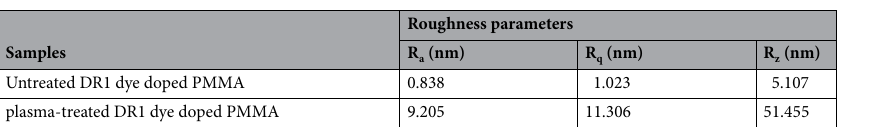
Table 2. Comparative presentation of roughness parameters (R a , R q , and R z ) of dye-doped PMMA polymer surfaces before and after argon glow discharge plasma treatment for 300 s. The roughness parameters include the arithmetic averages of the assessed values (R a ), the root mean square average of height deviations from the mean line (R q ), and the maximum peak to valley height (R z